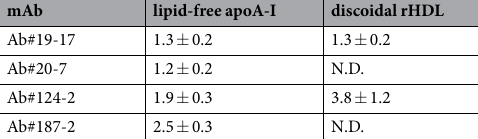
mAb lipid-free apoA-I discoidal rHDL